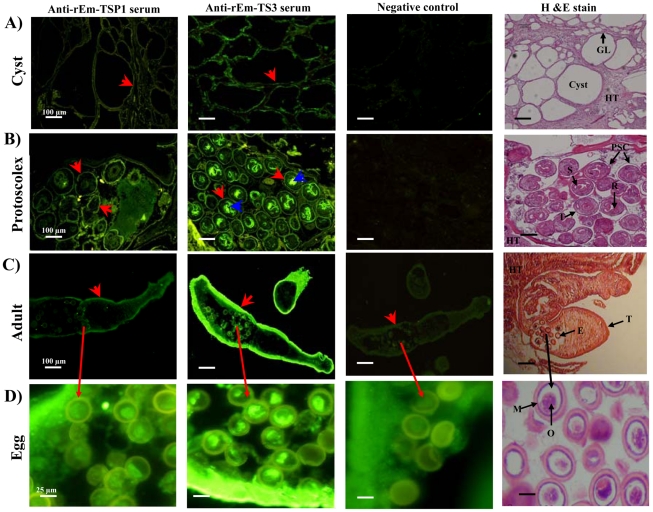
Immunolocalization of Em-TSP1 and Em-TSP3 on the larval and adult stages of E. multilocularis.Polyclonal rabbit thioredoxin-absorbed anti-Em-TSP1 and anti-Em-TSP3 antibodies, pre-immunized sera (negative controls), and Alexa Fluor R488 goat-anti-rabbit IgG (H+L) were used in the experiment. Parasites were frozen in Tissur-Tek O.C.T. Compound and cryosections were cut for immunohistochemistry. Localization of Em-TSP1 and Em-TSP3 in cysts (A), protoscoleces (B), adult worms (C) and eggs (D). The scale of microscopy images is shown on the lower right of each slice (scale bar = 100 µm in (A)–(C) and 25 µm in (D)). Fluorescence-labeled Em-TSP1 and Em-TSP3 on the surface of cysts, protoscoleces and adults are indicated by the red arrows. Expression of Em-TSP3 on the sucker and rostellum of the protoscoleces and on the oncospheres of eggs is indicated by the blue arrows. Pre-immunized serum (negative control) had no obvious reaction with any of fixed tissue sections. Microscopic images of HE-stained larvae, adults and eggs are shown as a reference. GL = geminal layer; PSC = protoscolex; HT = host tissue; T = tegument; R = rostellum; S = sucker; E = egg; O = oncosphere; and M = membrane.